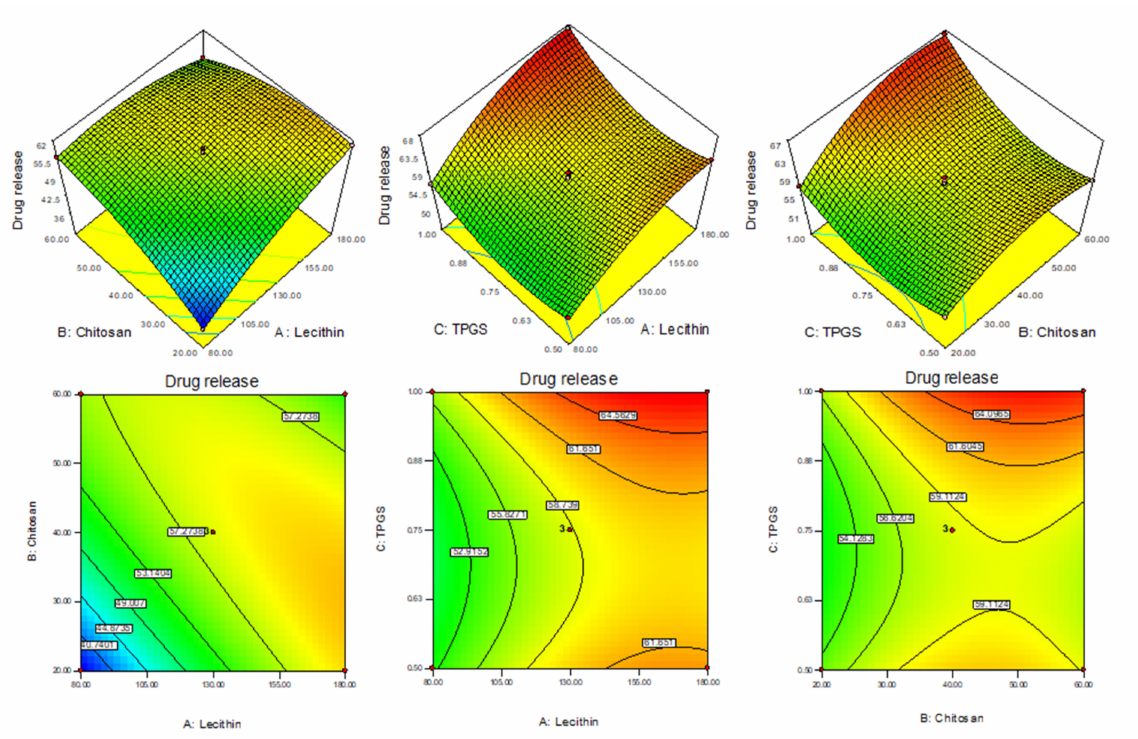
Figure 4. 3D response surface plot showing the effect on independent variables on drug release (Y 3 ). The factors A, B and C are model-coded terms for LC, CS and TPGS. The positive and negative signs expressed synergistic and antagonistic responses. The model F-value was found to be 1475.44 points toward the model was well fitted. From the polynomial equation, it was found that as the concentration of LC (A), CS (B) and TPGS (C) increases the particle size also increases. The factors A, B, C, AB, AC, B 2 , C 2 are the significant model term ( p < 0.05) and the remaining factors BC and A 2 are insignificant model terms ( p > 0.05). The lack of fit is significant ( p > 0.05) and it favors the fitted model. The adequate precession value >4 (145.02) showed the model was well fitted. The ANOVA